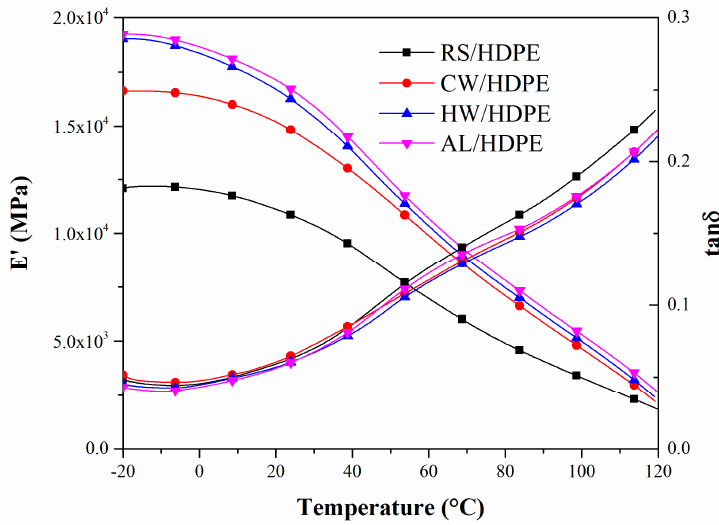
Figure 2. Storage modulus ( E' ) and mechanical damping (tan δ ) of RS/HDPE, CW/HDPE, HW/HDPE, and AL/HDPE as a function of temperature.